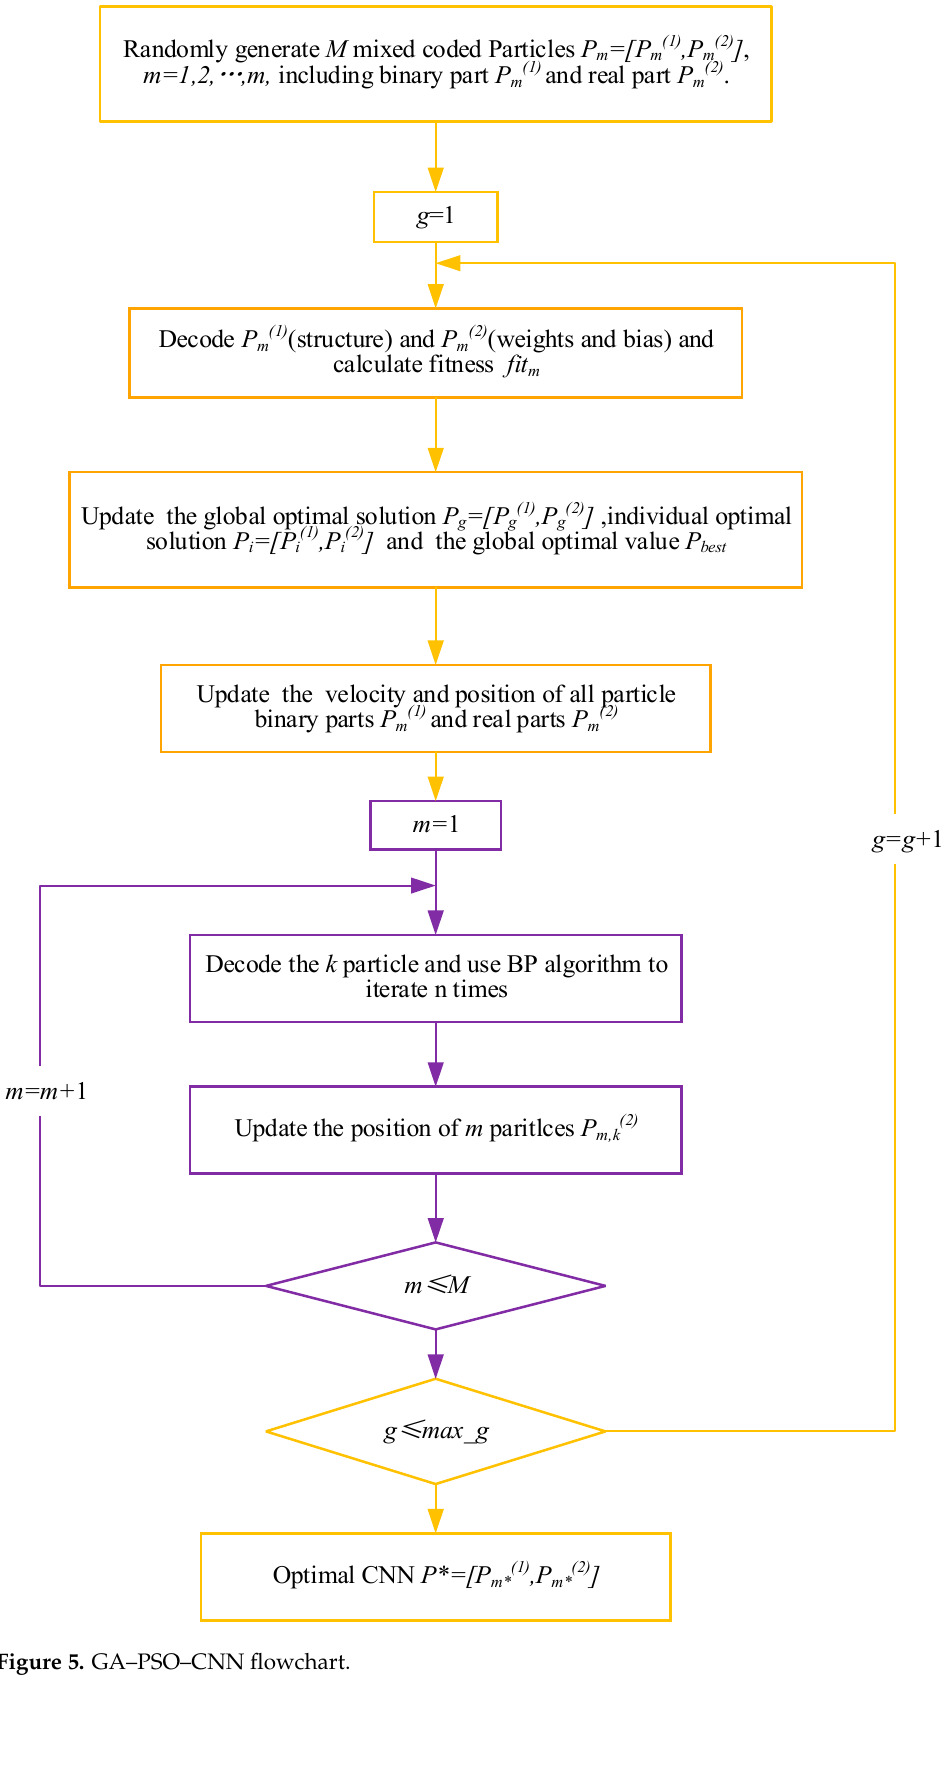
Figure 5. GA–PSO–CNN flowchart.